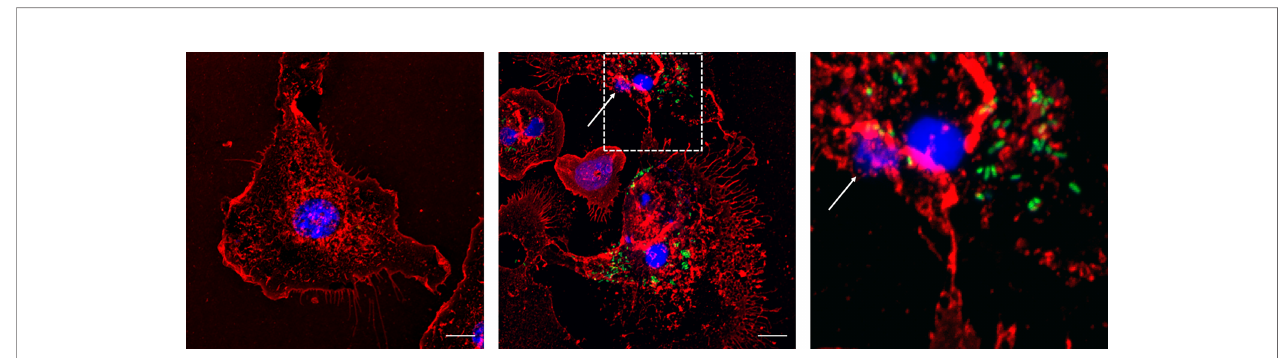
FIGURE 7 | Bone marrow derived macrophages infected with Salmonella enterica serovar Typhimurium LVR01 (40:1). Left panel: Uninfected cells (Control). Center panel: 30 minutes of infection. Right panel: zoomed-in image from central panel (dashed square). The images are maximum intensity z-projections of all the slices in the stack in the three channels. In red: membrane, blue: DNA, green: Salmonella . The arrows point out the presence of METs. The scale bar represents 10